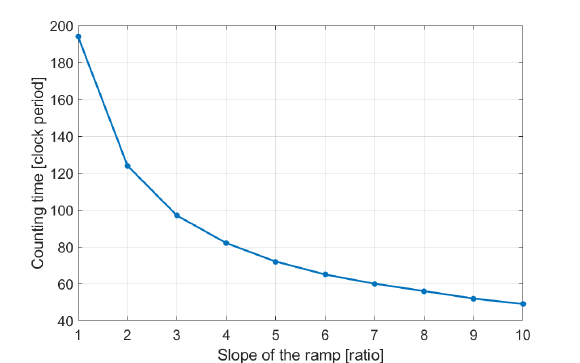
Figure 20. Simulation result of counting time with different